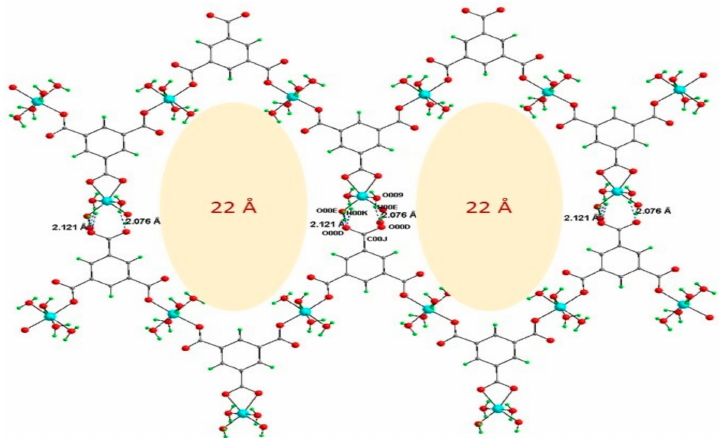
Figure 26. Zig-zag chains in [M 3 ( btc ) 2 (H 2 O) 12 ] [M = Ni, and Co] are connected via H-bonding forming a 2D sheet with void space of approximately 22 Å. Reprinted with permission from Ref. [58]. Copyright 2019